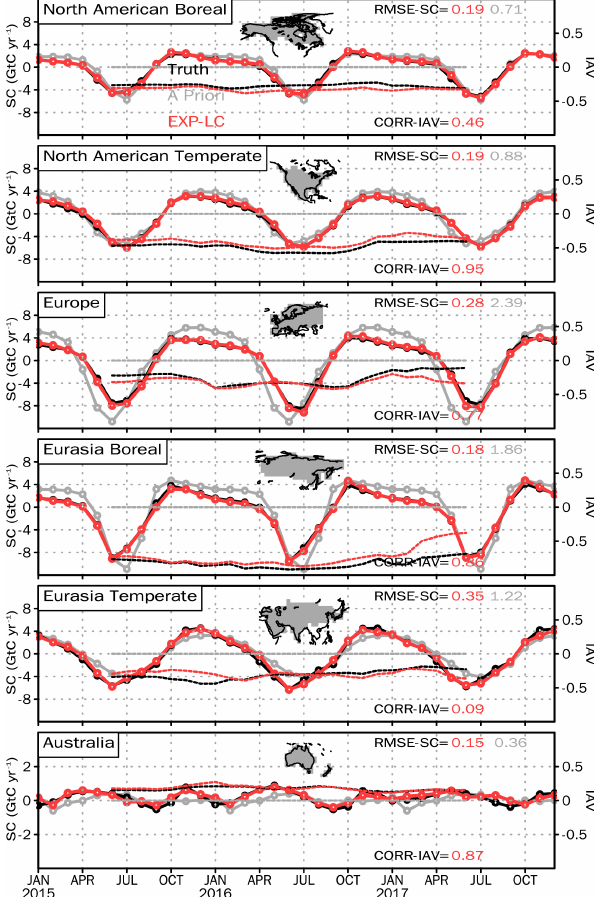
Figure 6. The FTA seasonal cycle (SC) and interannual variation (IAV) in truth (black), a priori (gray), and analysis of EXP-LC (red) over the Northern Hemisphere regions and Australia. The solid lines marked with open circles are the SC. The dashed lines are the IAV calculated from the original SC using a 12-month moving average method. The RMSE in the top-right corner is the SC root mean square error of the analysis (red) and the a priori (gray) calculated based on Eq. (12). The correlation (CORR) in the bottom-right cor- ner is the IAV correlation between the analysis and the truth (the red dashed line and the black dashed line). Note that there is no IAV in the a priori. Thus, there is no IAV correlation between the a priori and the